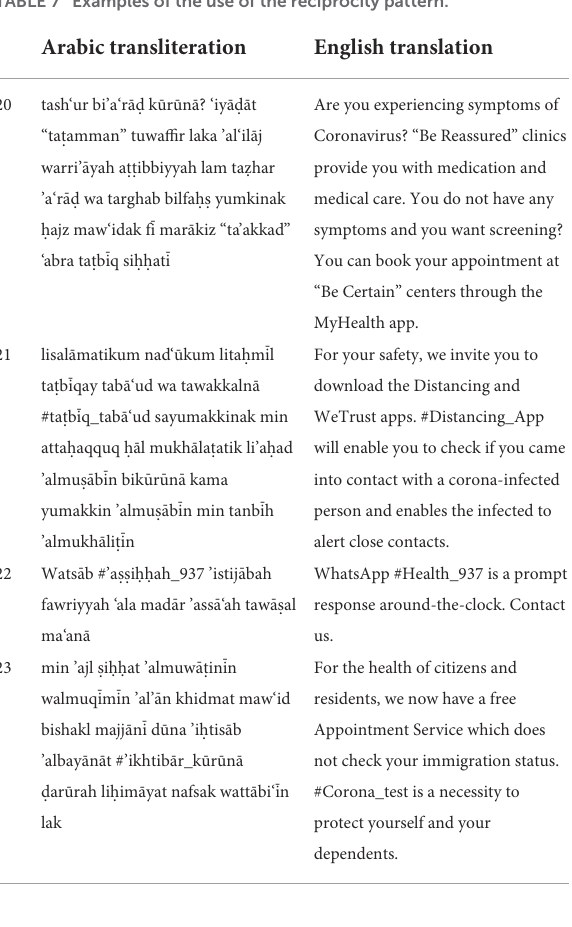
TABLE 8 Examples of the use of the unity-commitment pattern.